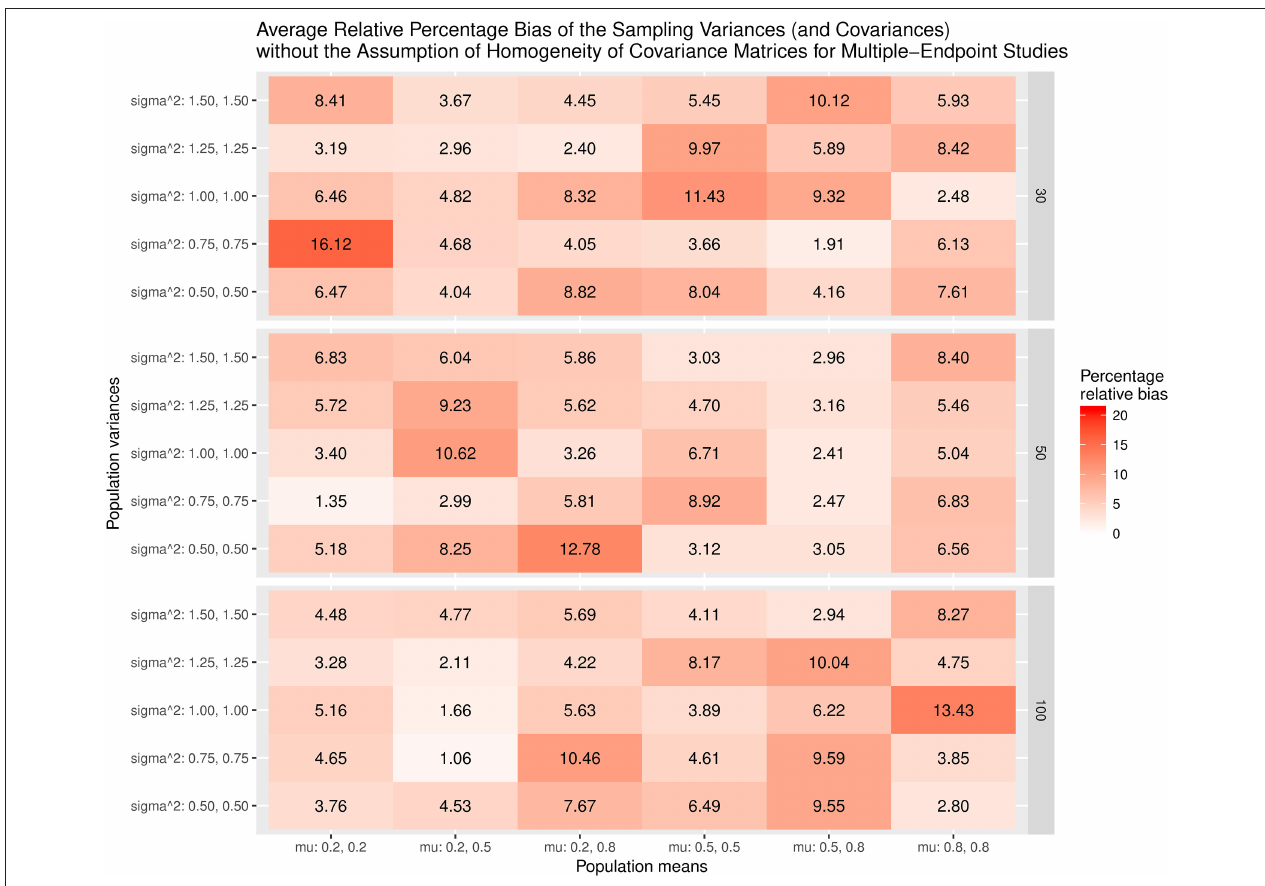
FIGURE 10 | Relative bias of the average of the sampling variances and covariance for the multiple-endpoint studies without the assumption of homogeneity of covariance matrices.